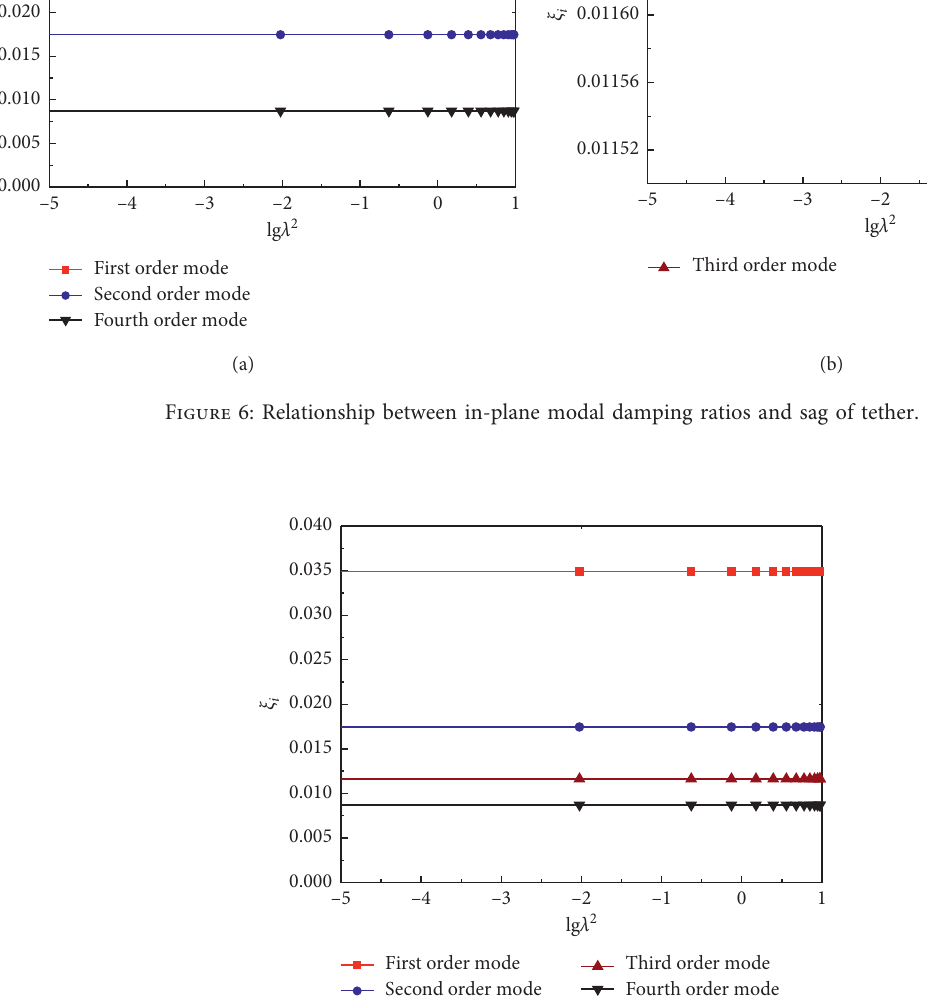
Figure 7: Relationship between out-of-plane modal damping ratios and sag of